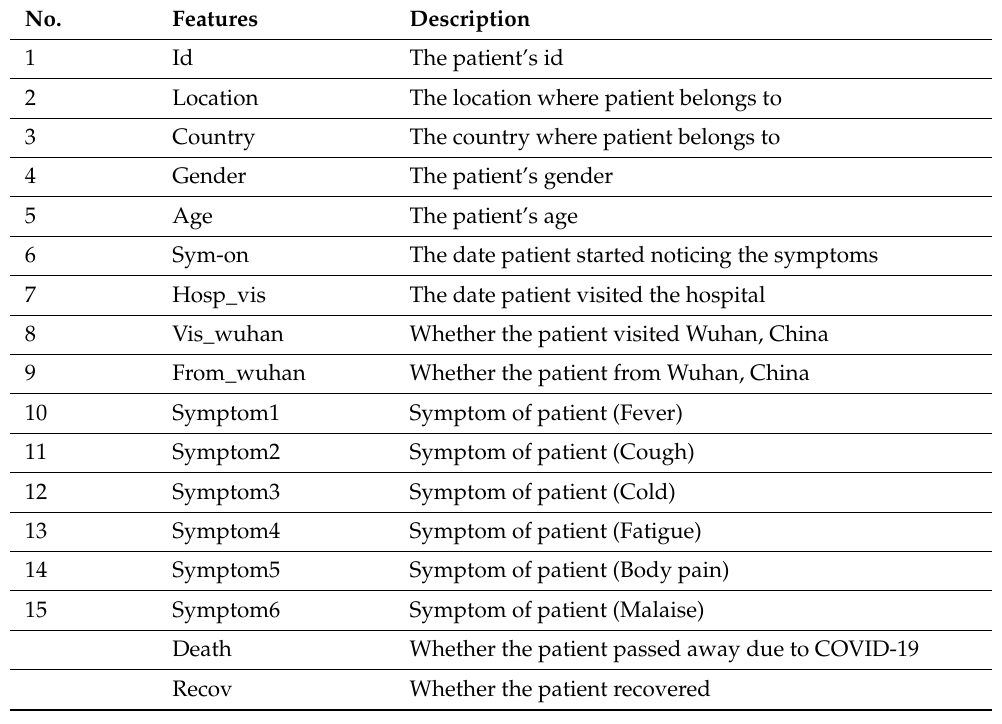
Table 10. Description of COVID-19 dataset.